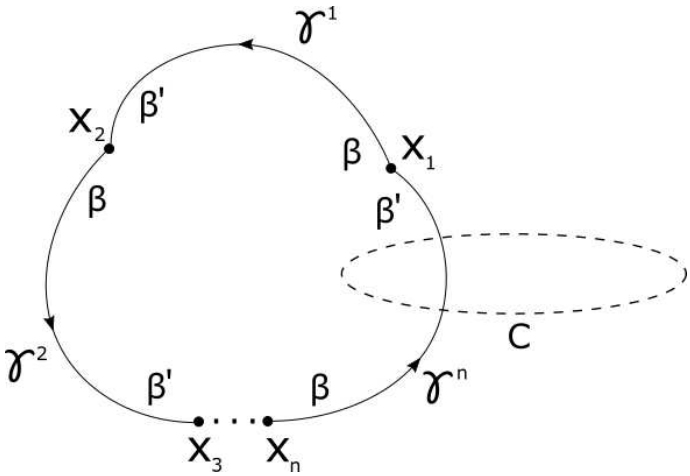
Figure 2 . A chain configuration, with n correlated instantons, linking a Wilson Loop